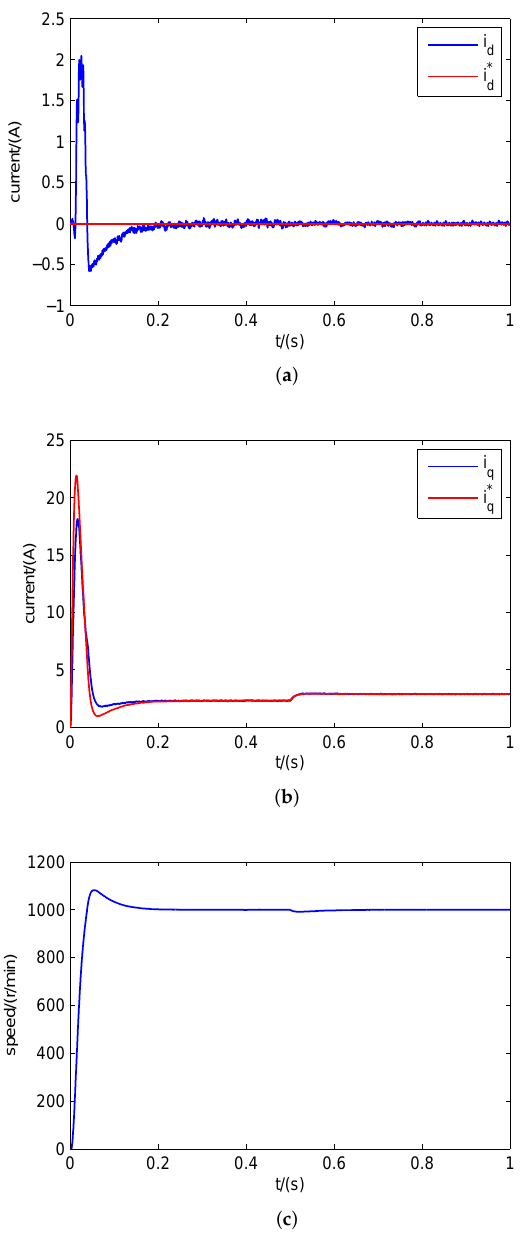
Figure 3. Simulation results with proportional plus integral (PI) control: ( a ) d-axes current; ( b ) q-axes current; and ( c ) speed